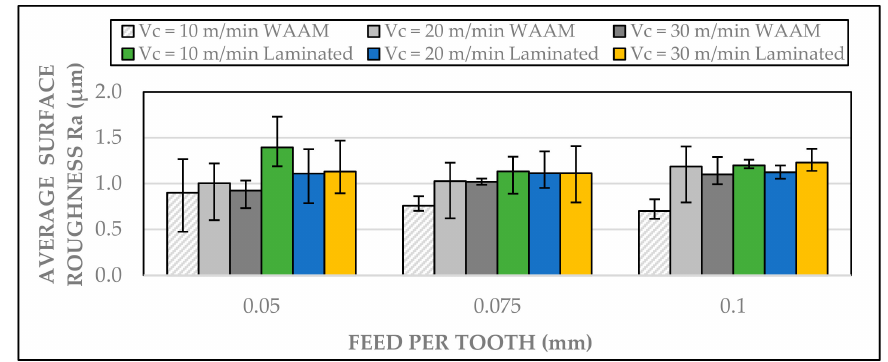
Figure 14. E ff ect of the cutting parameters and material manufacturing process on the surface roughness of the